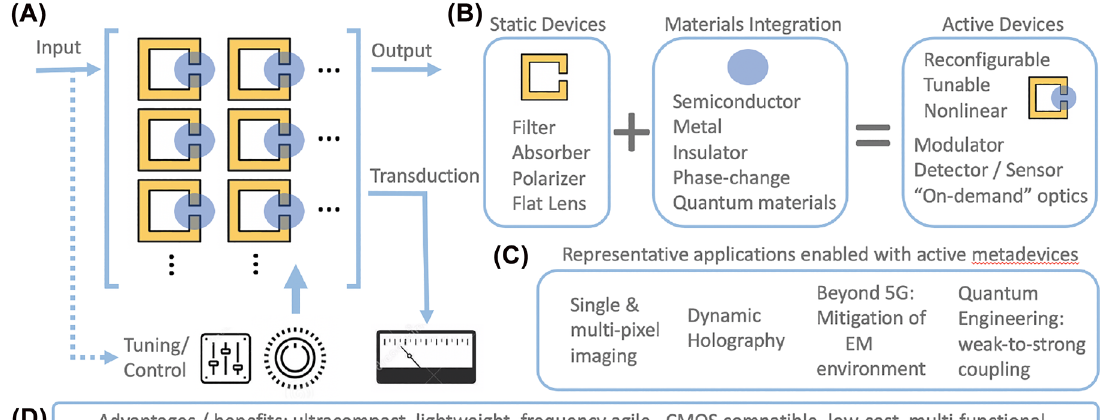
Figure 1: Schematic overview of active metamaterials. (A) Incident electromagnetic radiation (the input) interacts with a metamaterial structure to modify the output characteristics of the radiation. Material integration (blue circles) allows for tuning of the metamaterial response to control the output or enable signal transduction. The input could also modify the metamaterial response (e.g., a nonlinear interaction). (B) Materials integration imbues static metamaterials with electromagnetic properties that can be tuned or